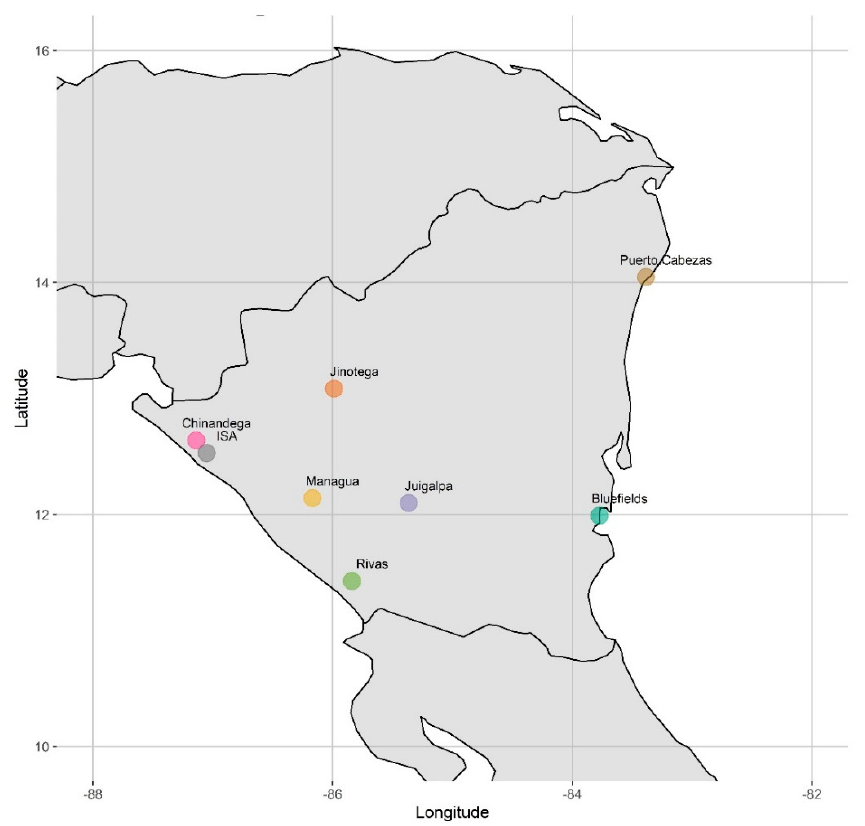
Figure 4. Histograms of monthly-averaged daily maximum temperatures at all seven ASOS Network monitors and ISA, 1996–2014, and map of the locations of each monitor.